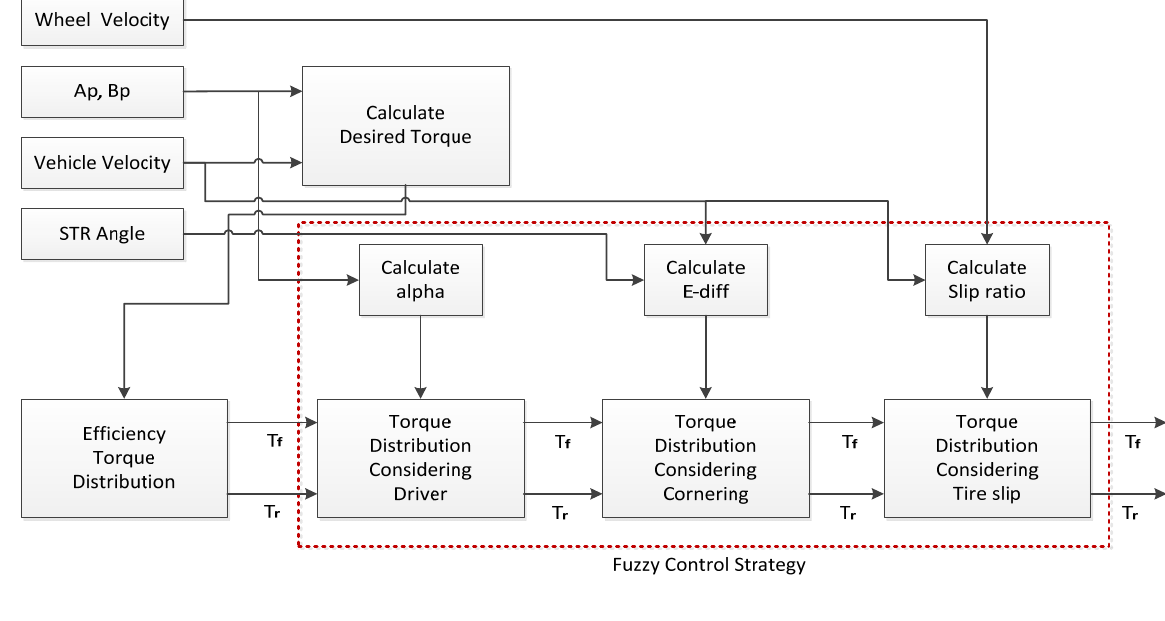
Figure 12. Integrated torque distribution